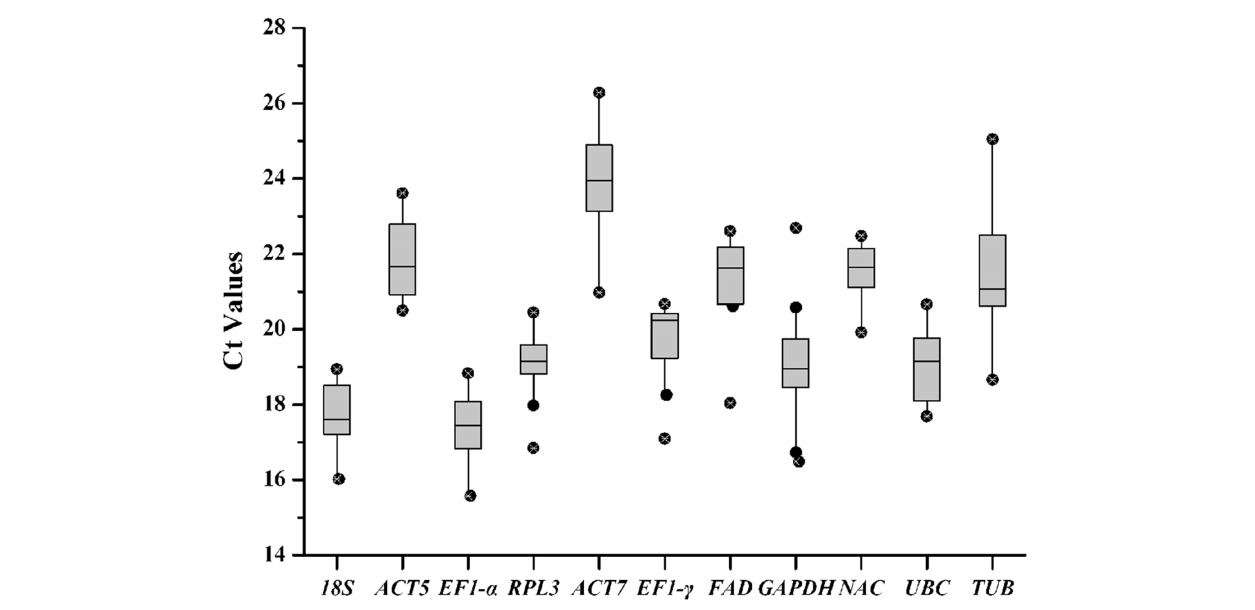
FIGURE 2 | Quantitative real-time polymerase chain reaction Ct values for reference genes. Ct values for each reference gene in all of the R. molle samples. A line across the box denotes the median. The box denotes the 25 and 75% percentiles, whisker caps represent maximum and minimum values, and dots represent